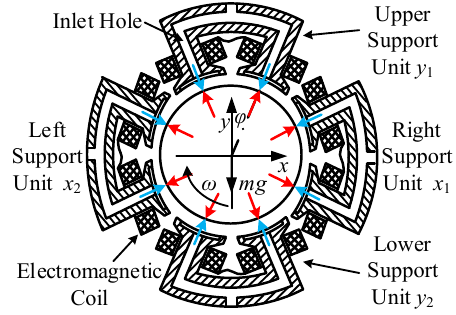
Figure 7. Mechanical model of the protection device for the “rotor- hydrostatic